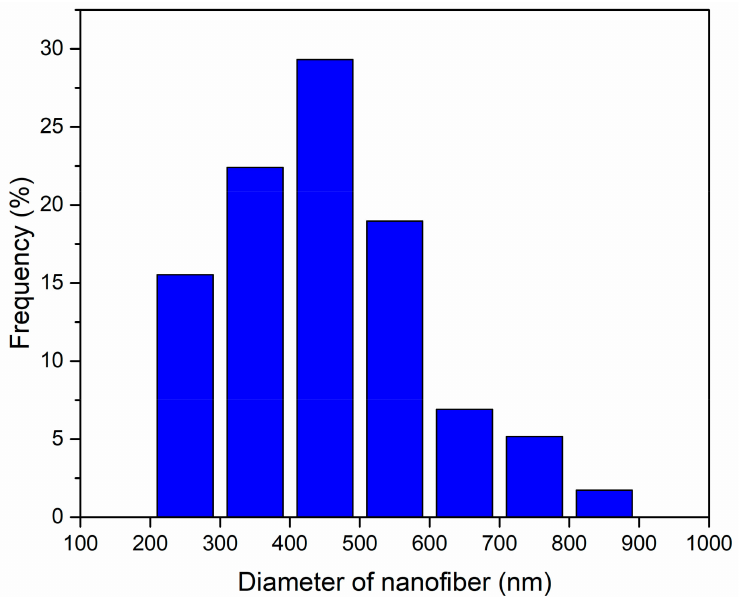
Figure 3. The nanofiber diameter distribution of electrospun 20%PES-100%Zeolite13X membranes based on the images from